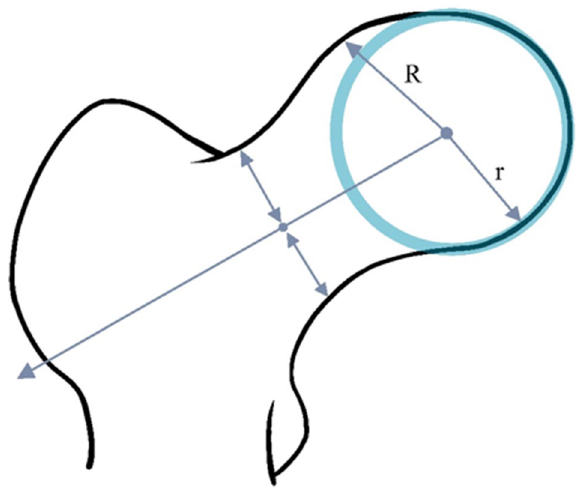
Figure 2. Schema of the definition of a PGD-positive case. The overhang is measured by drawing a circle around the femoral head on the anteroposterior view. Even a small overhang of the femoral head (R > r) is considered a PGD-positive case. PGD, pistol grip deformity.